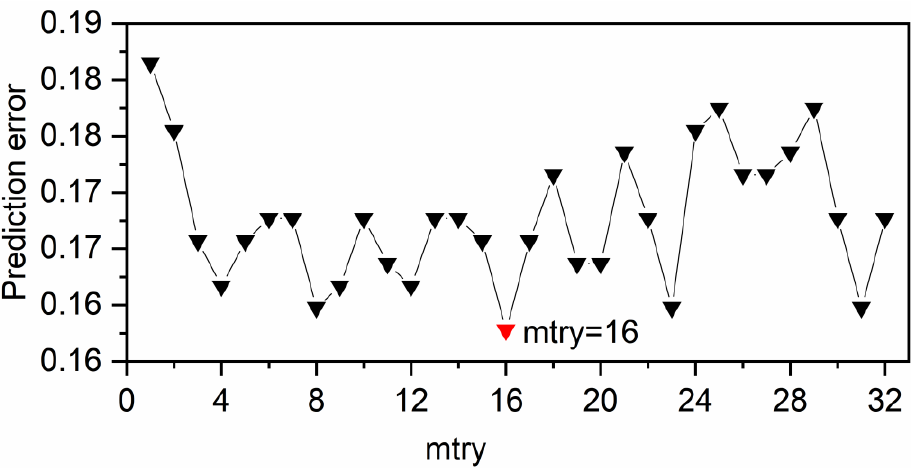
Figure 7. Prediction error of Random Forest model with different mtry.